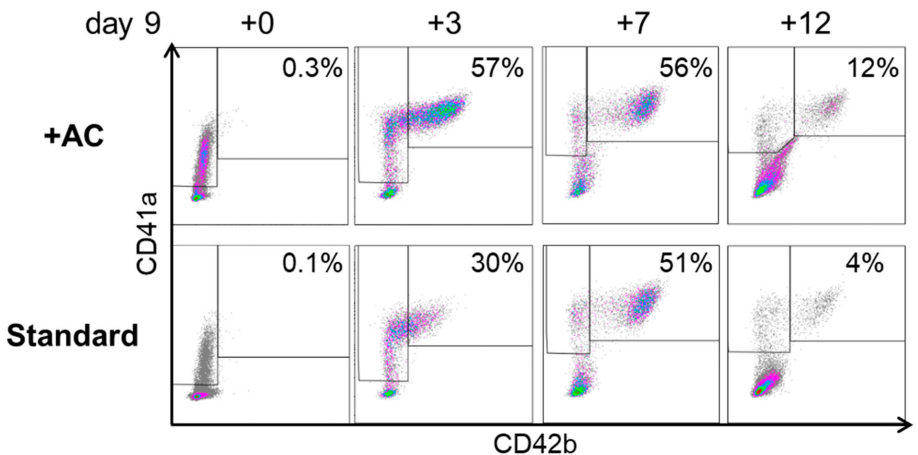
Figure A2. Representative flow cytometry dot plots of megacaryocyte maturation with (top row, +AC) or without initial induction (bottom row, Standard) of UCB144-CT2-C hiPSCs during stage III culture analysed for CD41a/CD42b reactivity at indicated time